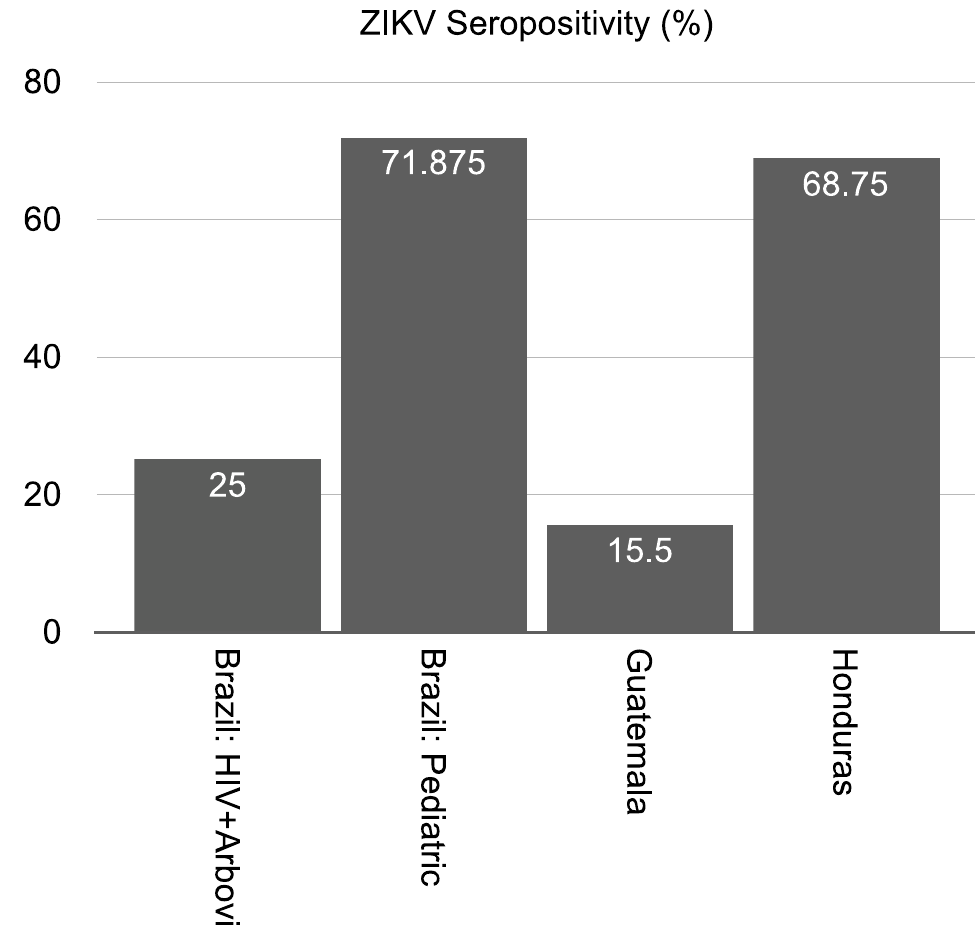
Figure 1. ZIKV seropositivity quantified across each uncharacterized patient cohort at the early and intermediate stages of the ZIKV epidemic. Positivity rate was measured according to the results from the peptide-based ELISA method on human samples collected from four countries with endemic circulation of ZIKV.